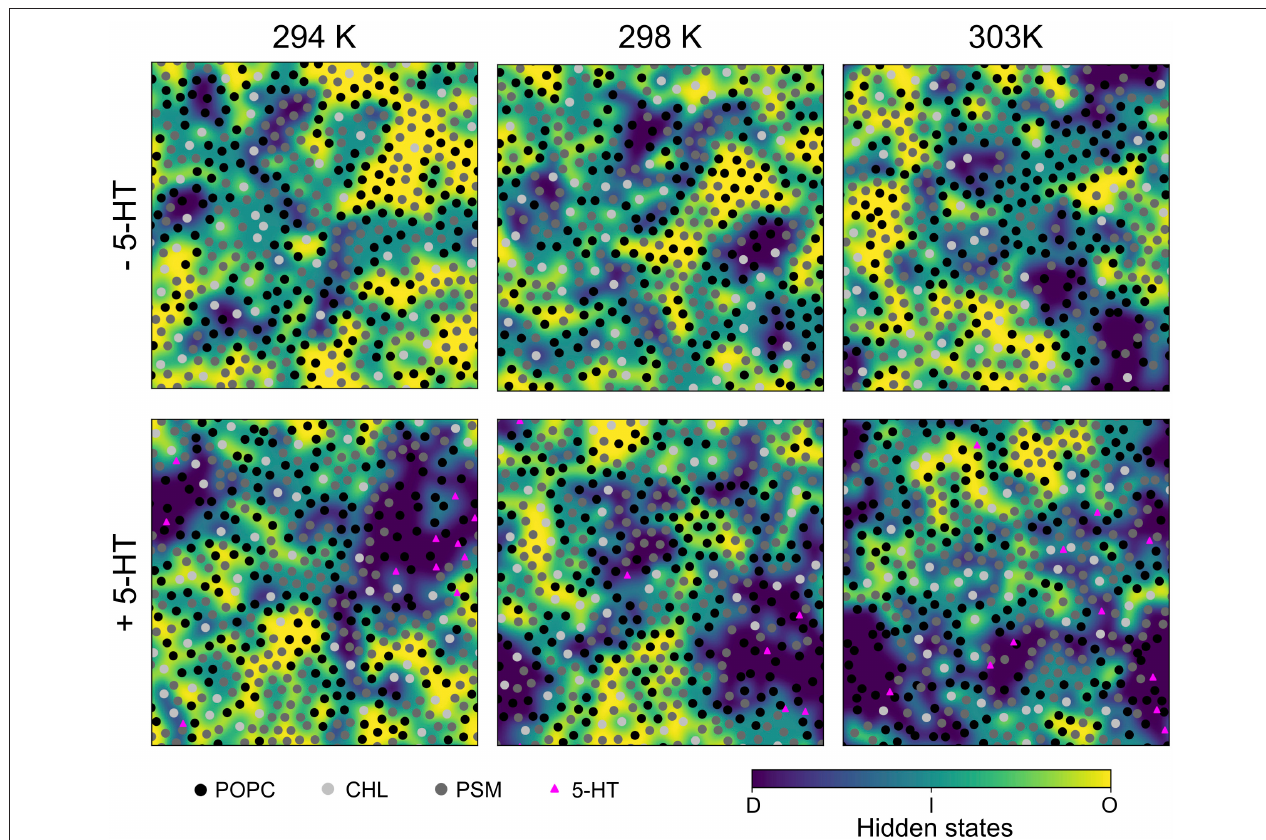
FIGURE 2 | Last snapshots of HMM-assigned lipid order states. A Hidden Markov Model was used to assign ordered (“O,” yellow ), disordered (“D,” violet ), and intermediate (“I,” light blue ) states to lipids based on their P2 order parameters as emission states. The emission states and initial probabilities were derived from the L O / D system at 303K. The lipid center of mass positions are marked by shaded circles, the positions of bound serotonin by